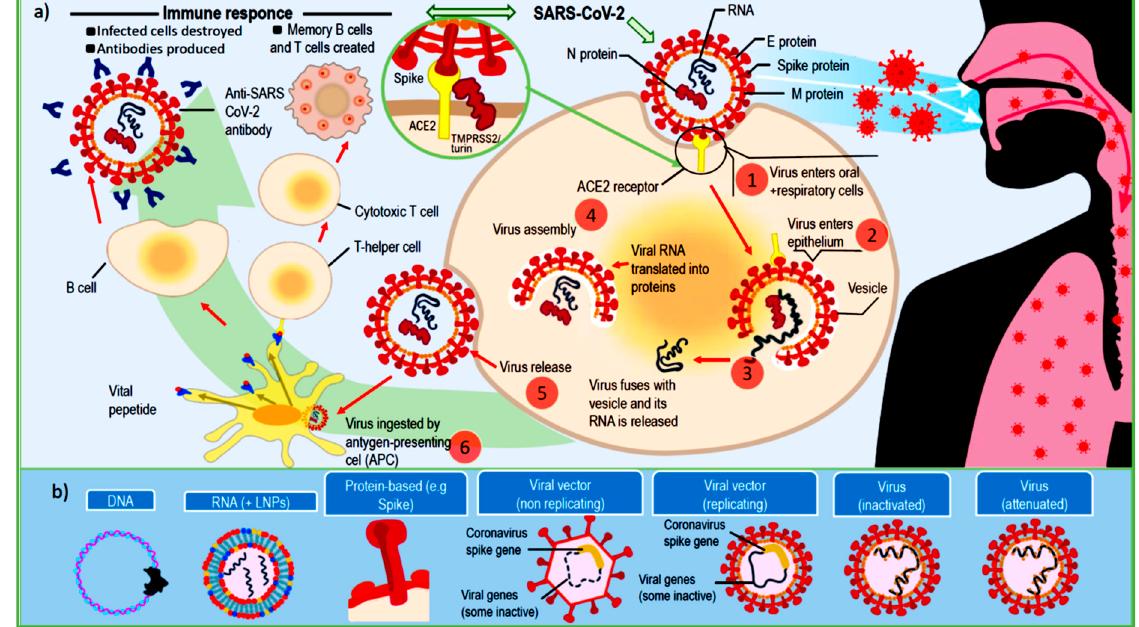
Figure 10. Diagram of ( a ) transmission and life cycle of the SARS-CoV-2 coronavirus; ( b ) preventing modes of SARS-CoV-2 coronavirus infection.